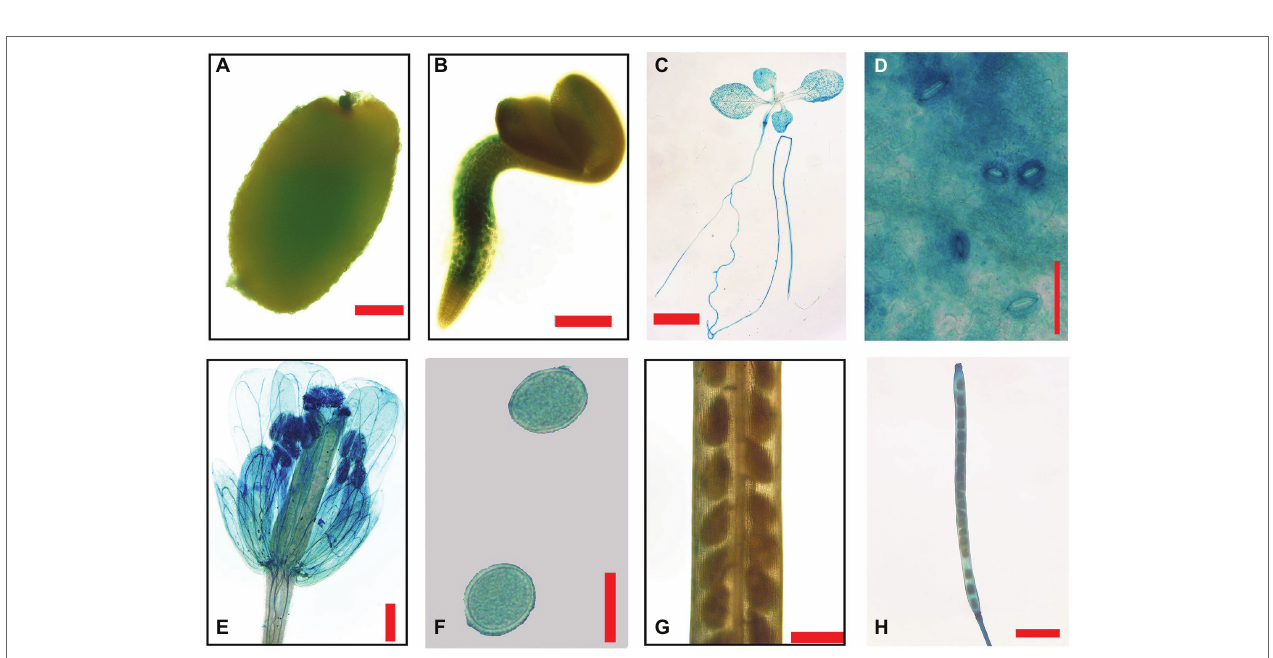
FIGURE 5 | GUS staining in different tissues of transgenic Arabidopsis with GmEXLB1::GUS . (A) Germinating seed. The scale bar = 100 μm. (B) Three-day-old seedlings. The scale bar = 200 μm. (C) Seven-day-old seedlings. The scale bar = 2 cm (D) Stomata. The scale bar = 50 μm. (E) Mature flower. The scale bar = 500 μm. (F) Pollen grain. The scale bar = 20 μm. (G) Immature seeds. The scale bar = 500 μm. (H) Immature pod. The scale bar = 2 cm.